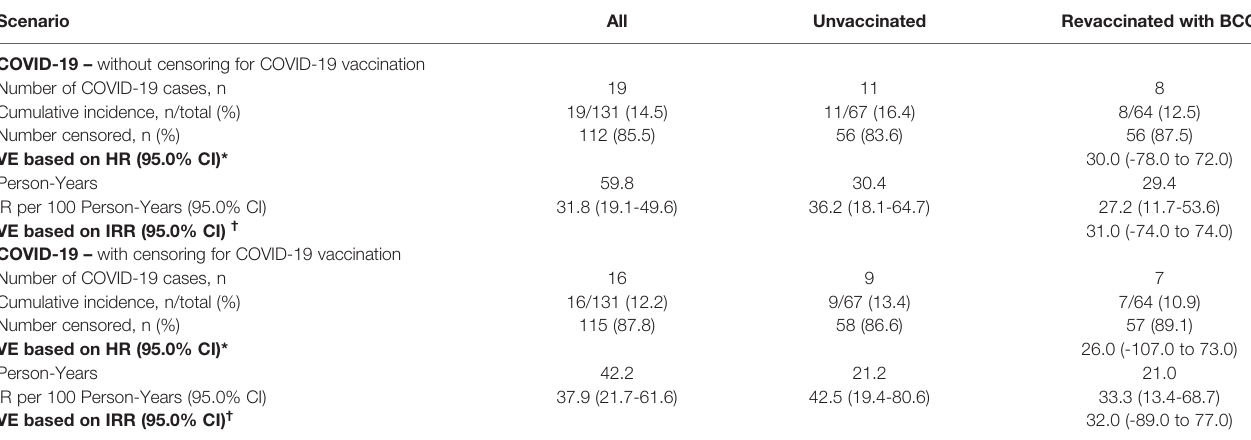
Scenario All Unvaccinated Revaccinated with